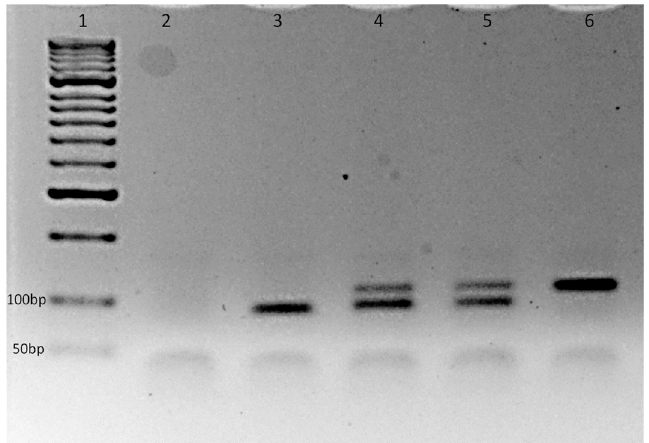
Figure 2. Representative electrophoretic profiles of the allele-specific polymerase chain reaction (AS-PCR) for the detection of the knock-down resistance ( kdr ) allele 1016G in in the vssc gene in Aedes albopictus specimens. Agarose gel 3%. Lane 1: molecular weight marker (50 bp, Bioline, Memphis, TN, USA); lane 2: negative control; lane 3: homozygote 1016V/1016V; lanes 4 and 5: heterozygote 1016V/1016G; lane 6: Homozygote 1016G/1016G.